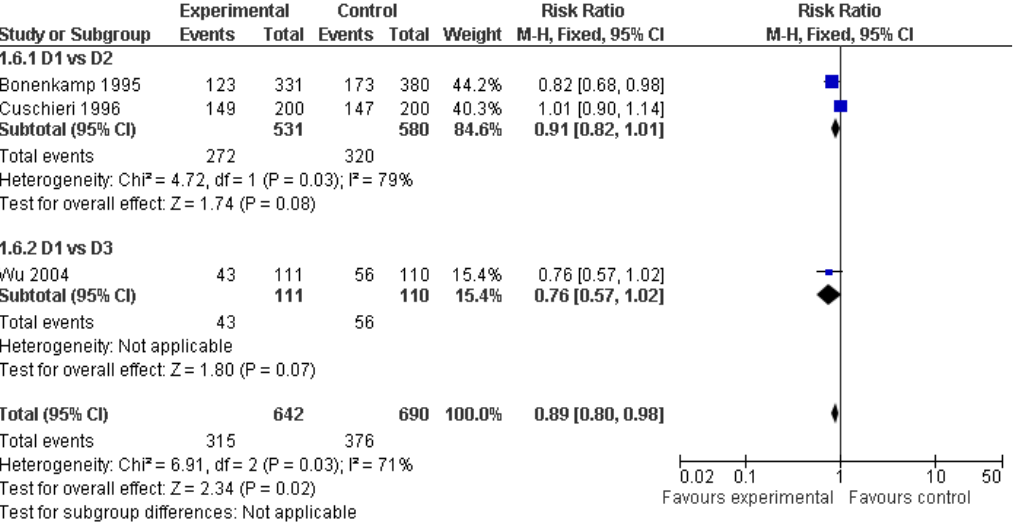
FIGURE 6 – Meta-analysis of recurrence. Effects estimates (odds ratio; 95% CI). Pooled treatment effect is shown as a diamond that spans the 95% CI. Significant statistical heterogeneity between studies results. Overall effect with statistically significant difference favoring D2 or D3 lymphadenectomy